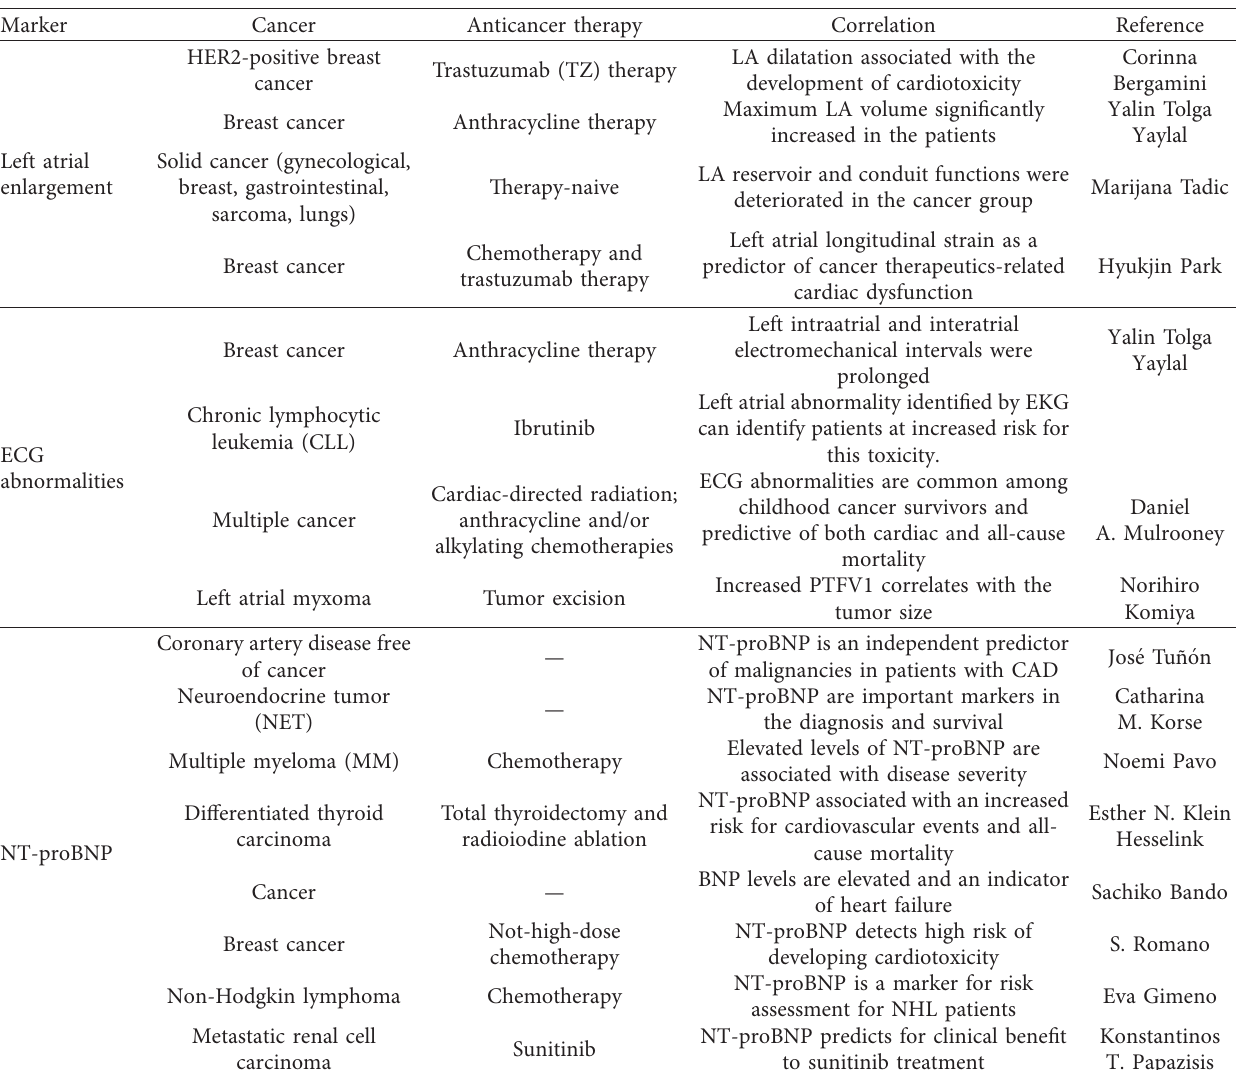
Table 2: Atrial cardiomyopathy associated markers in patients with cancer